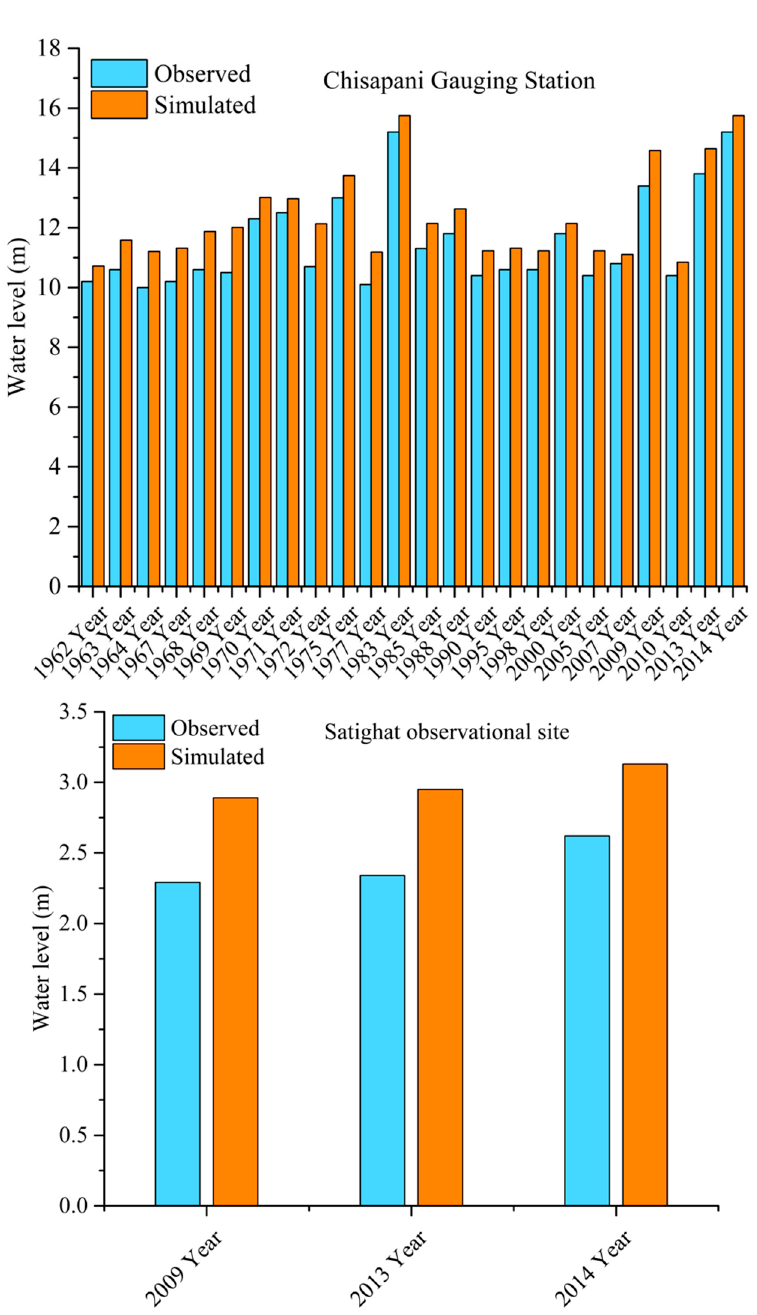
Figure 6. Comparison between observed and simulated water levels at Chisapani gauge ( upper ) and the field observation site Satighat; ( lower ) in the river channel during major historical flood events between 1962 and 2014, as used for model performance evaluation.